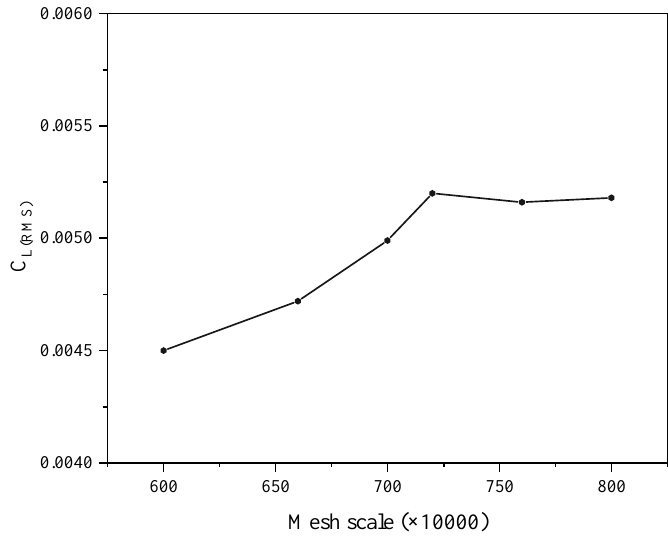
Figure 6. Grid independence verification.